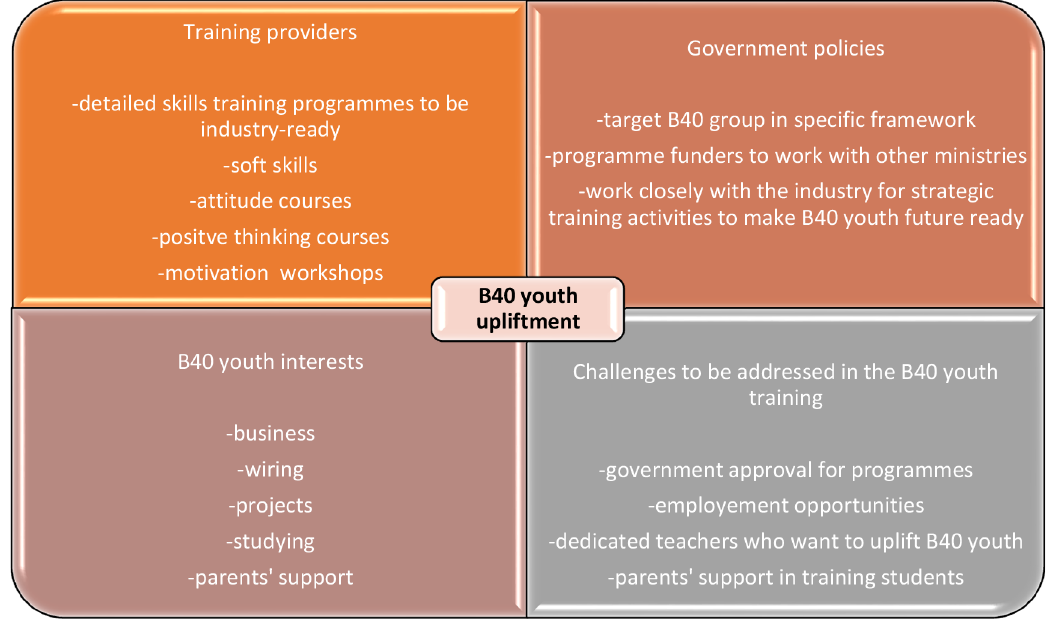
Figure 4. Framework for multi-stakeholder involvement towards the upliftment of B40